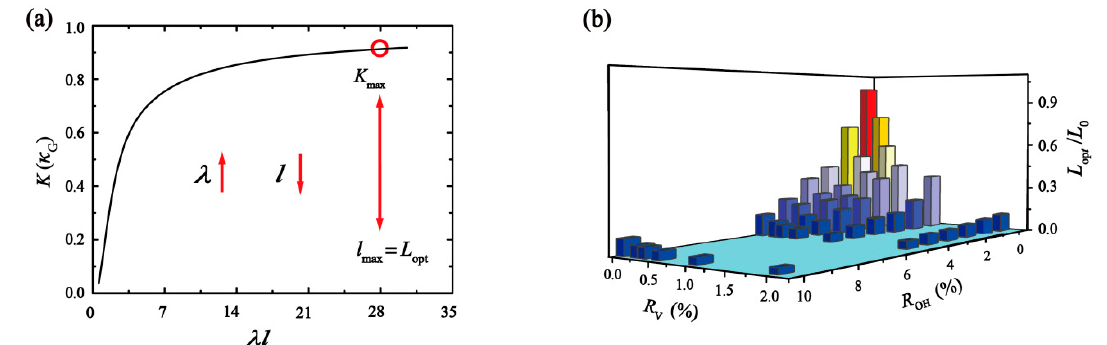
l λ Figure 9. ( a ) The total thermal conductivity of GO films as a function of λ l (dimensionless). The point